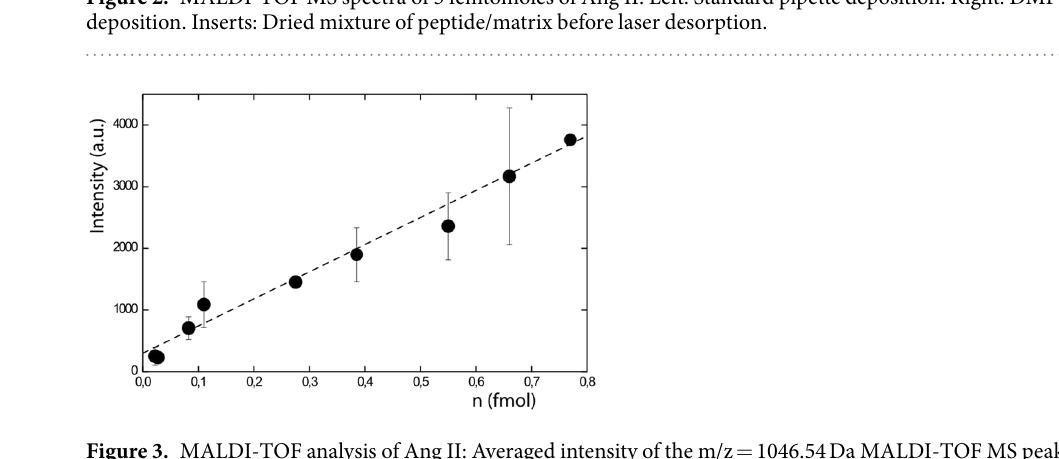
Figure 3. MALDI-TOF analysis of Ang II: Averaged intensity of the m/z = 1046.54 Da MALDI-TOF MS peak in function of the averaged calculated amount of Ang II